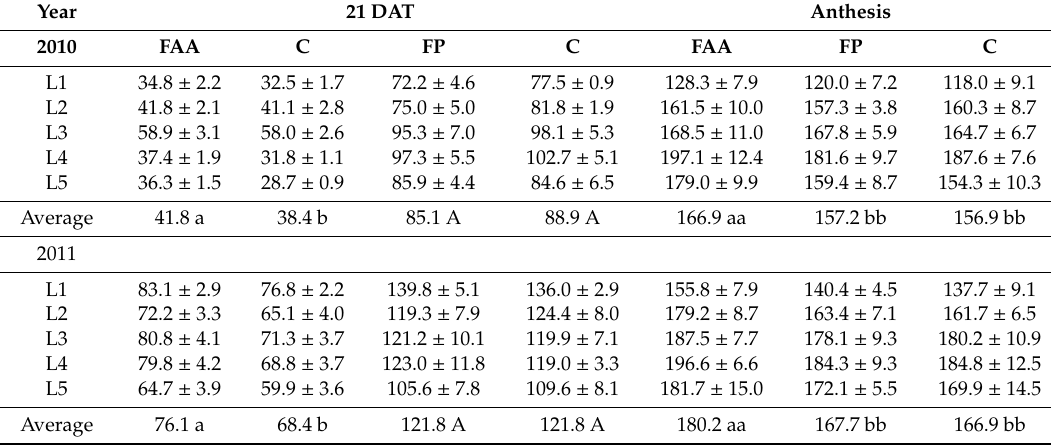
Table 8. E ff ects of applied fertilizers on maize plant height (cm plants − 1 ) and standard error ( ±